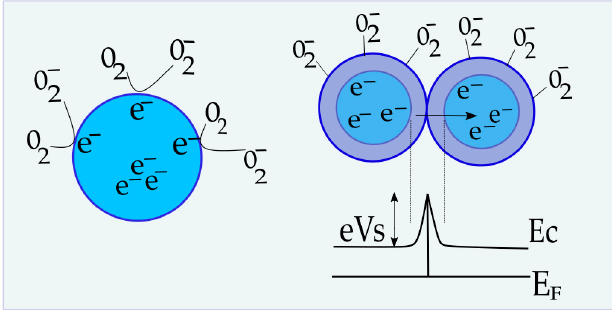
Figure 17. The illustration on the left is the receptor function of the semiconductor; right is the